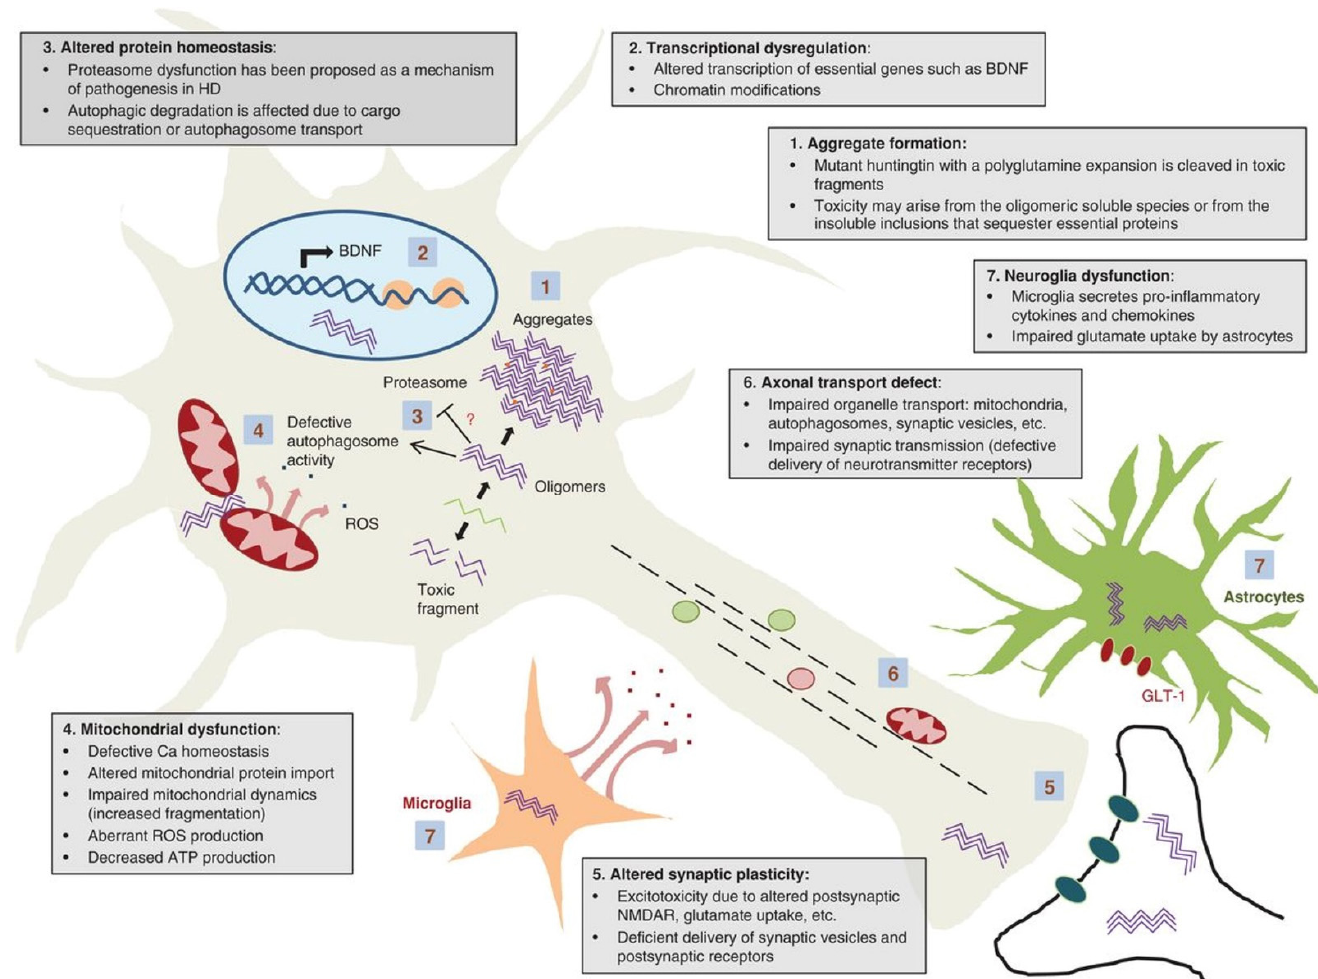
Figure 1. Selected mechanisms of HD Pathogenesis. ( 1 ) Aggregation of mutant huntingtin, ( 2 ) Transcriptional dysfunction, ( 3 ) Proteasomal and autophagy dysfunction, ( 4 ) Mitochondrial dysfunction, ( 5 ) Alteration of synaptic plasticity, ( 6 ) Defective axonal transport, ( 7 ) Microglial dysfunction. The nuclear transport failure is not depicted. The figure was adapted from Jimenez-Sanchez et al. (2017) [37] and is replicated with permission from Cold Spring Harbor Laboratory Press, obtained on 15 December 2021.